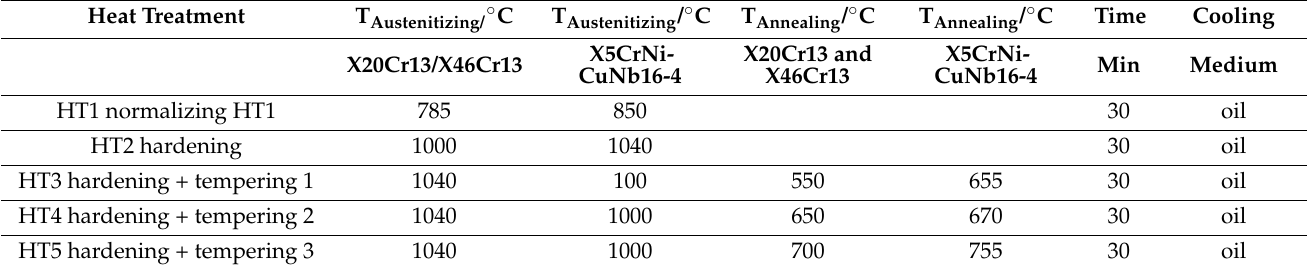
Table 8. Heat treatment protocol for X20Cr13, X46Cr13, and X5CrNiCuNb16-4. Heat Treatment